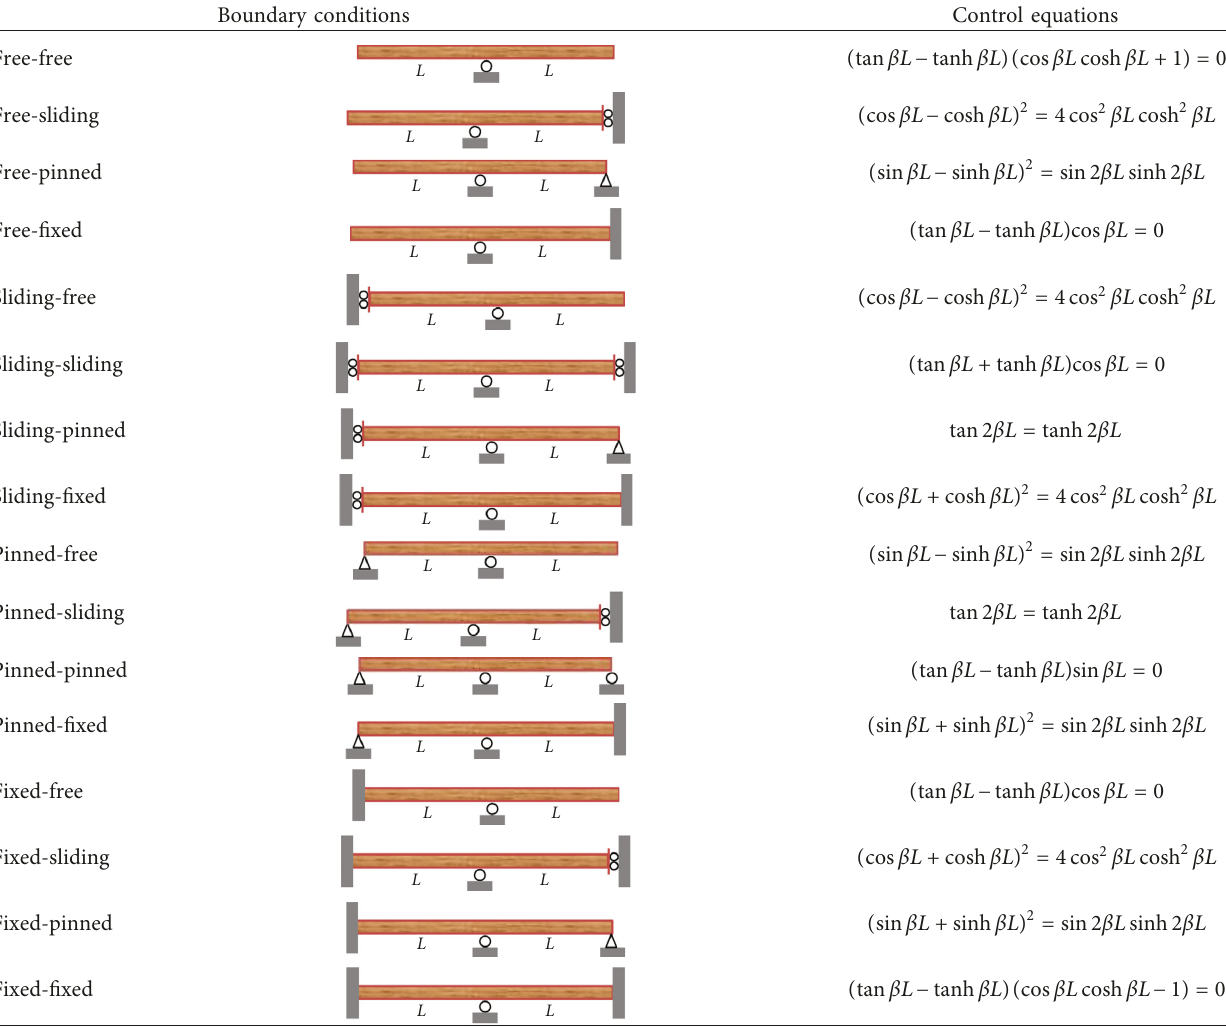
Table 2: Frequency equations for two-span beams with various end support conditions.